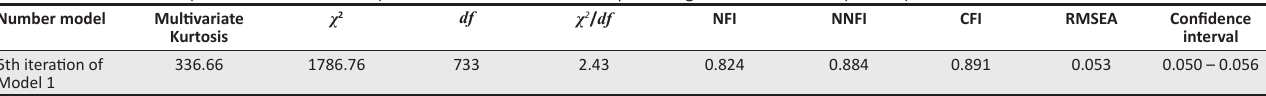
TABLE 4: Goodness-of-fit (Yuan–Bentler correction) indices for Structural Model 1 predicting turnover intention ( n = 509). Number model